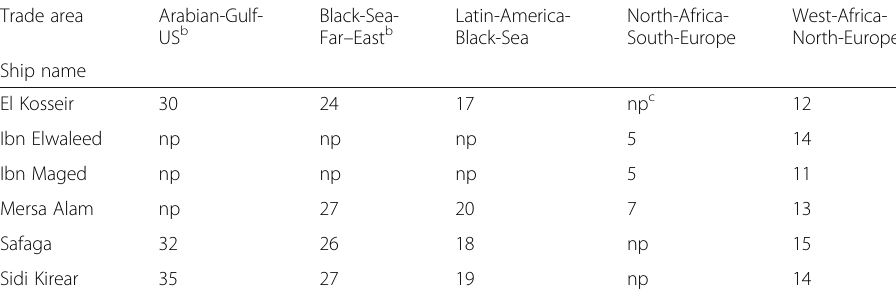
Table 13 Average voyage time a (days) in 2018, classified by ship and trade area Trade